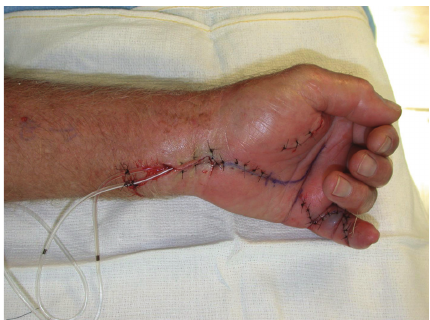
F 7: Mycobacterial tissue cultures demonstrating Mycobac- terium marinum